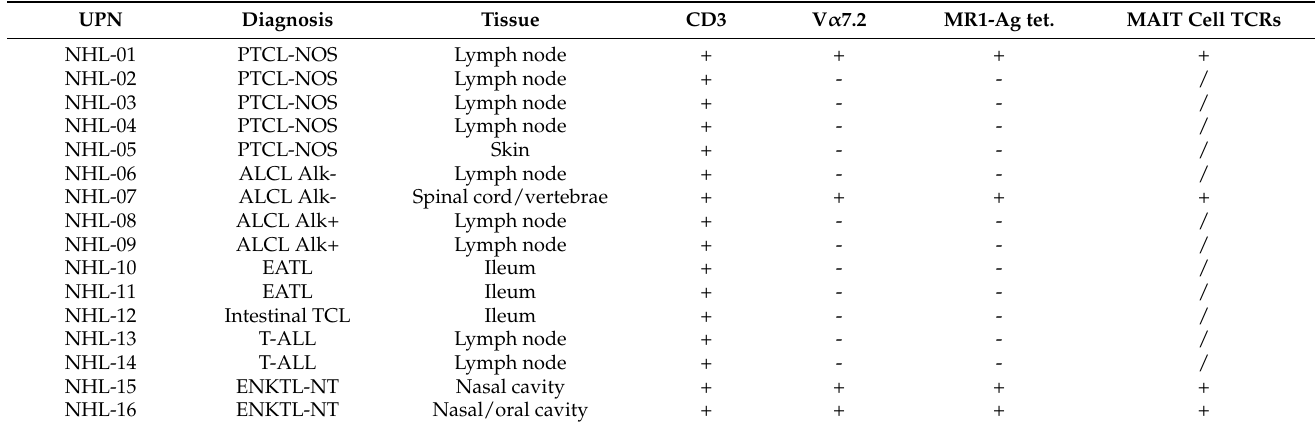
Table 2. Results of immunofluorescence and PCR, followed by DNA sequencing in our case